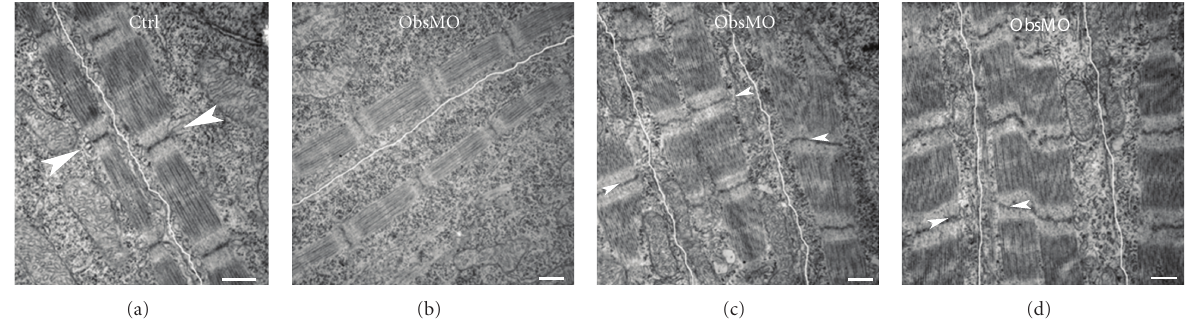
Figure 9: New myofibril assembly occurs along the sarcolemma with a consistent relationship between myofibrils in adjacent myocytes. Skeletal muscles from 20hpf zebrafish embryos were evaluated by transmission electron microscopy. (a) In control (Ctrl) embryos, new myofibril assembly occurs along the sarcolemma (white line) with a slight o ff set in the alignment of the Z disks (arrowheads). (b)–(d) In obscurin morphant (ObsMO) embryos, myofibril assembly continues to occur adjacent to the sarcolemma (white lines) but there is a greater distance and a greater variability in the distance between superficial myofibrils in adjacent cells. There was also a greater variability in the alignment of Z disks across adjacent myocytes, ranging from very o ff set ((c): arrowheads) to nearly precisely aligned ((d): arrowheads). Scale bars are 500